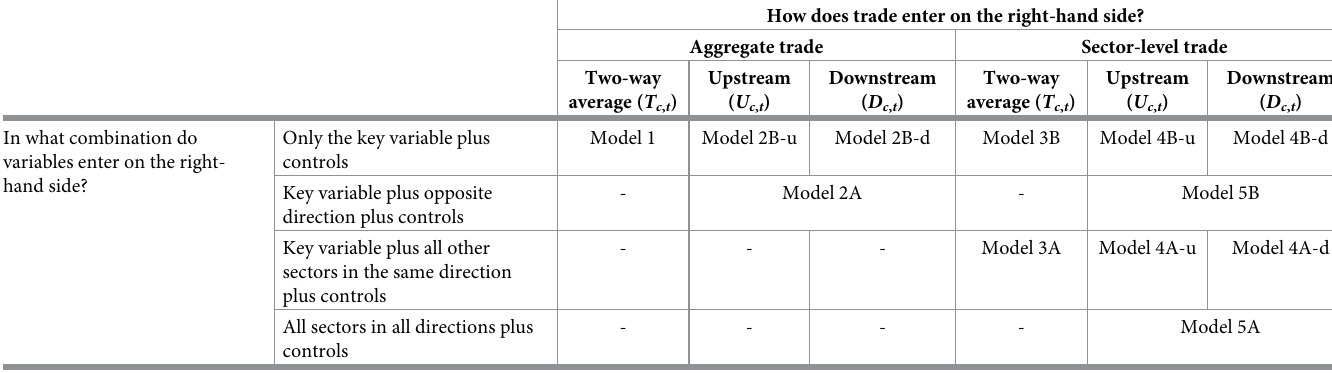
Table 3. Summary of the different model setups used in the analysis.